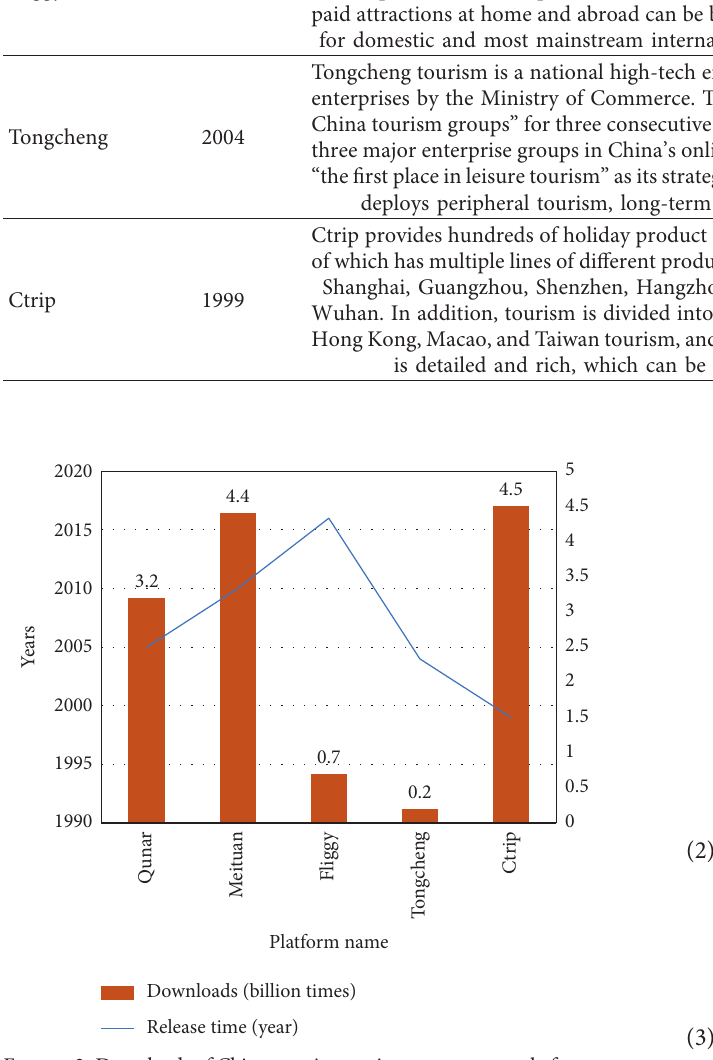
Figure 2: Downloads of Chinese major tourism e-commerce platforms. Table 5: Main target groups for customized